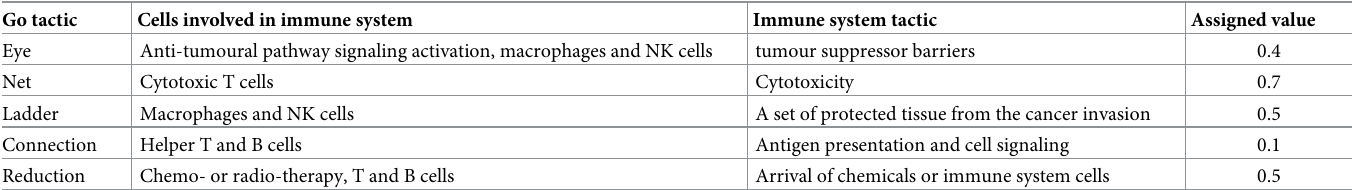
Table 2. Correspondence between cancer and immune system tactics to Go